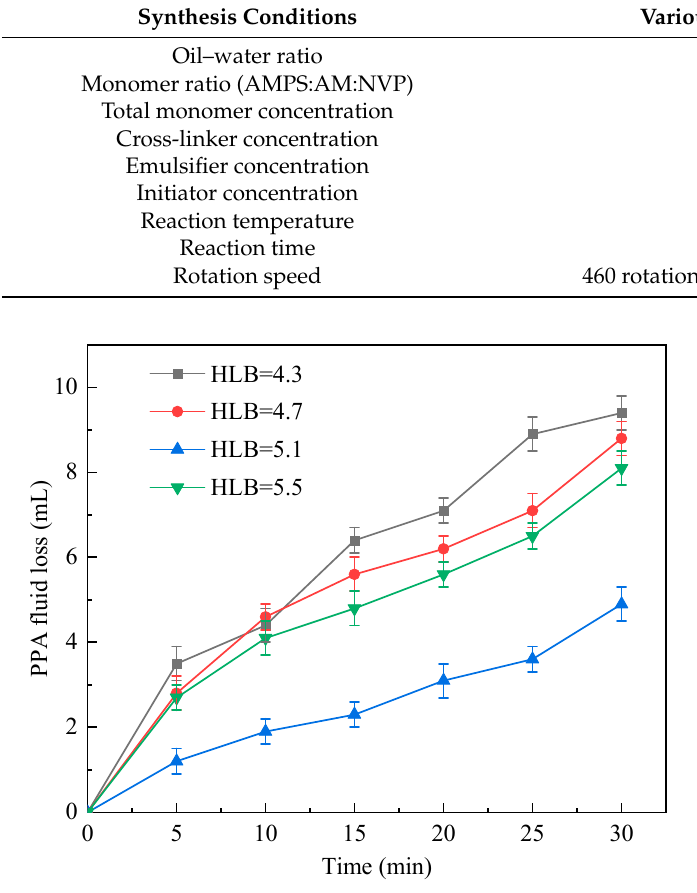
Figure 1. PPA fluid loss vs. time in cases of different HLB values.